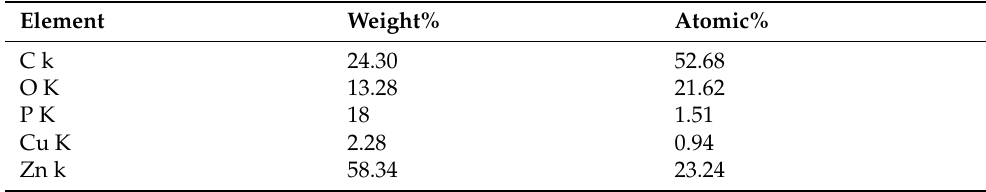
Figure 5. ( a ) 2500 resolution ( b ) 5000 resolution and ( c , d ) are same resolution of Scanning electron microscopy image of the zinc oxide nanoparticles at various magnifications.